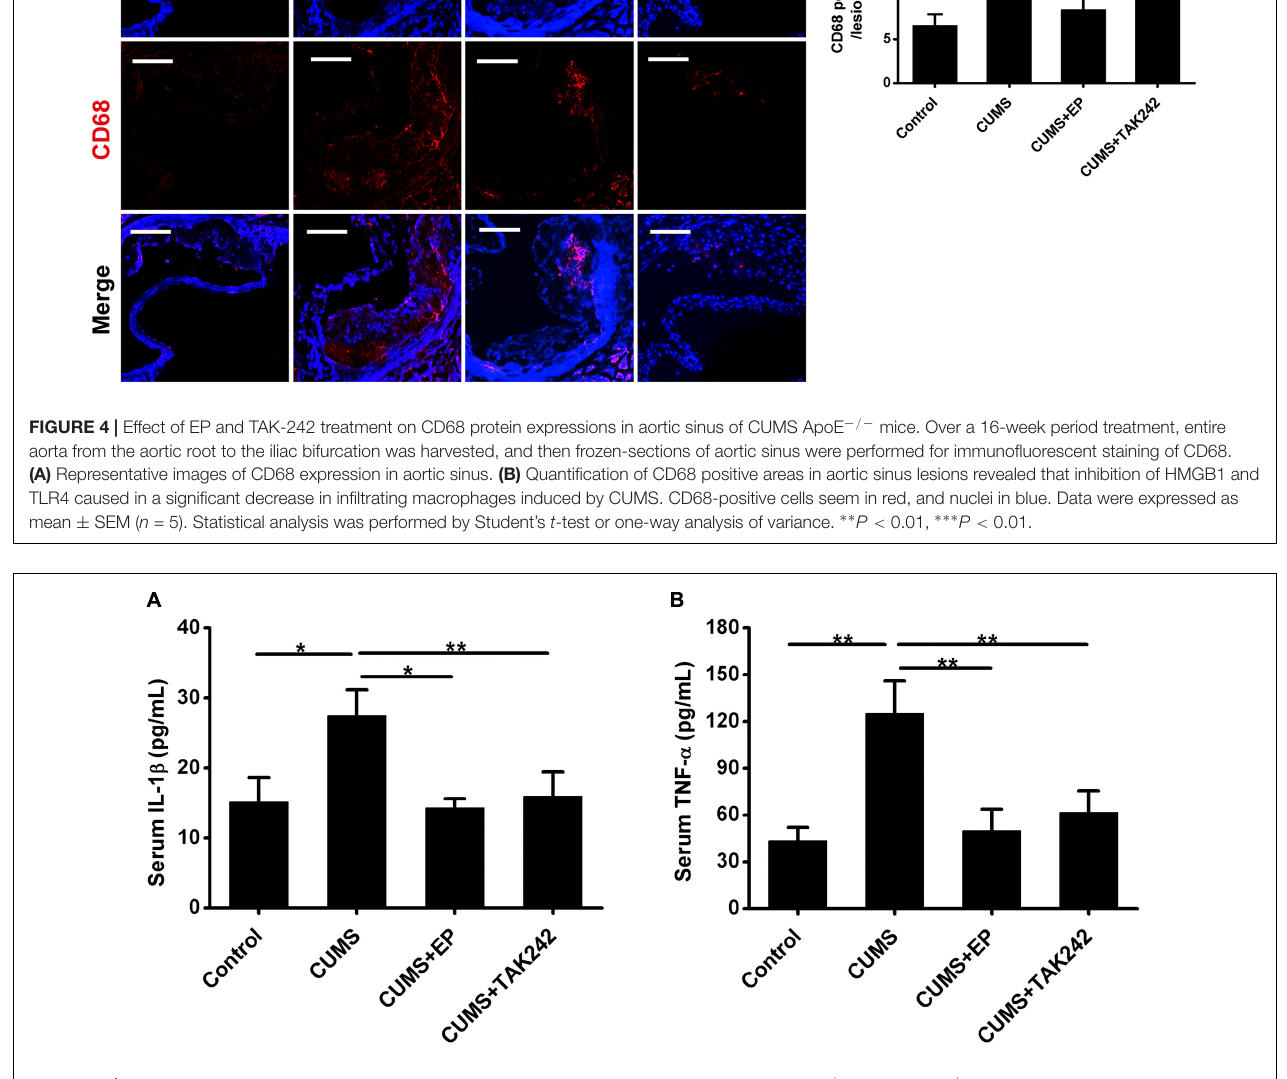
FIGURE 5 | Effect of EP and TAK-242 treatment on serum IL-1 β and TNF- α protein levels in CUMS ApoE − / − mice. ApoE − / − mice were injected with vehicle (PBS), EP (50 mg/kg, once daily), or TAK-242 (0.3 mg/kg, twice a week) for consecutive 16 weeks by intraperitoneal injection 30 min prior to CUMS. Over a 16-week period treatment, blood samples were collected for detection of serum IL-1 β and TNF- α protein levels by ELISA. (A,B) Quantification of expression levels by ELISA indicated increases in serum IL-1 β and TNF- α protein contents in CUMS apoE − / − mice, whereas HMGB1 inhibition by EP or TLR4 inhibition by TAK-242 abolished CUMS-induced increases in serum IL-1 β and TNF- α levels. Data were expressed as mean ± SEM ( n = 15). Statistical analysis was performed by Student’s t -test or one-way analysis of variance. ∗ P < 0.05, ∗∗ P <